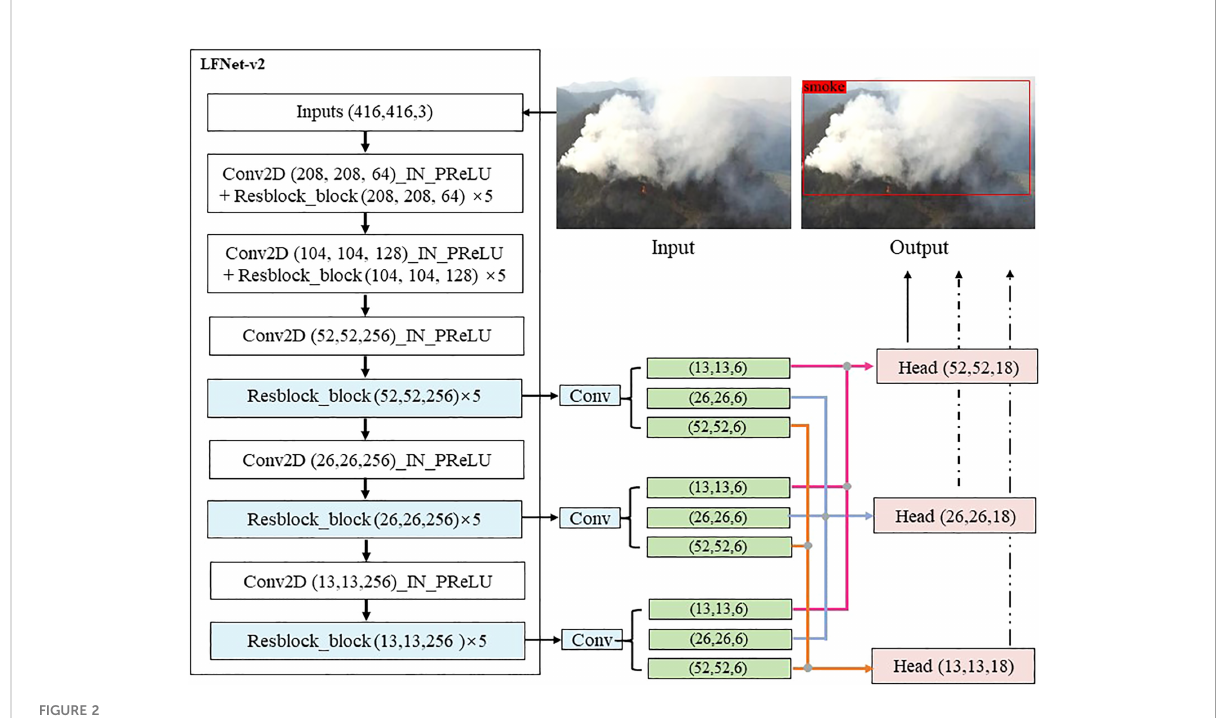
FIGURE 2 The framework of the proposed